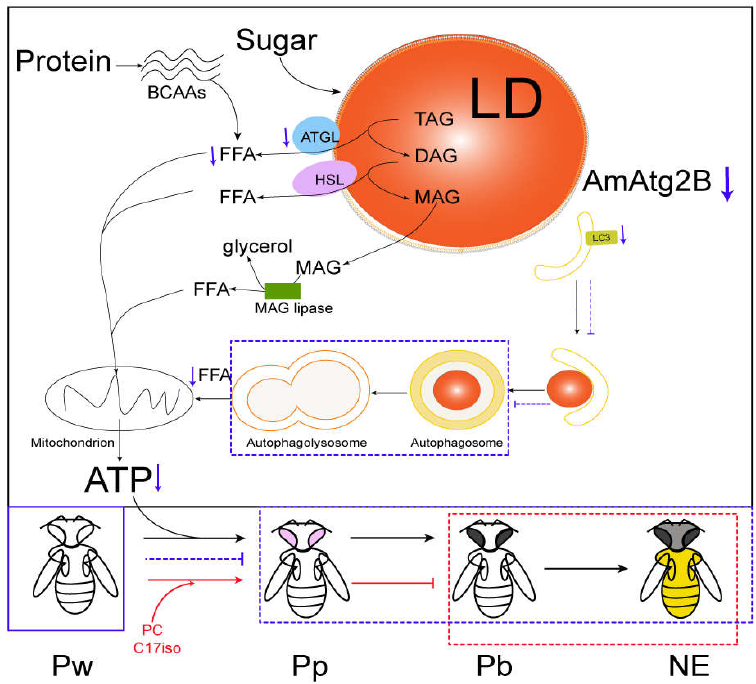
Figure 8. Proposed model of the AmAtg2B function. Low level of AmAtg2B in transcription and translation can reduce the activity of lipophagy, affect lipid lipolysis in vivo, and lead to abnormal development arrest at Pw, which rescued by both PC and C17iso significantly increased the proportion of Pp (Figure 7c). Unfortunately, there was no improvement in the eclosion rate, and not all of the pupae injected Anti−Atg2B antibody could emerged as adults. PP: prepupa, Pw: white−eyed pupae, Pp: pink−eyed pupae, Pb: black−eyed pupae; NE: Newly emerged adult.